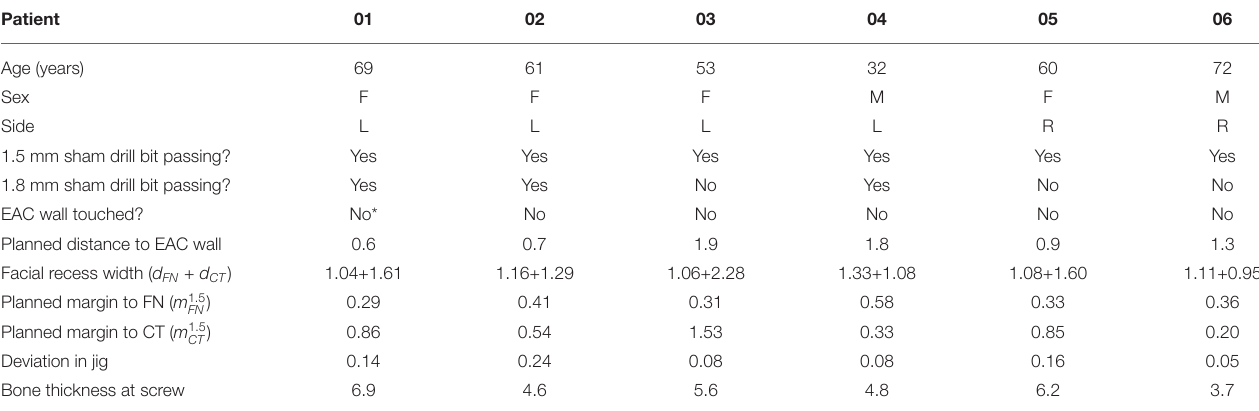
TABLE 1 | Demographics, the width of the facial recess, distances from the planning, and results of the first six patients.